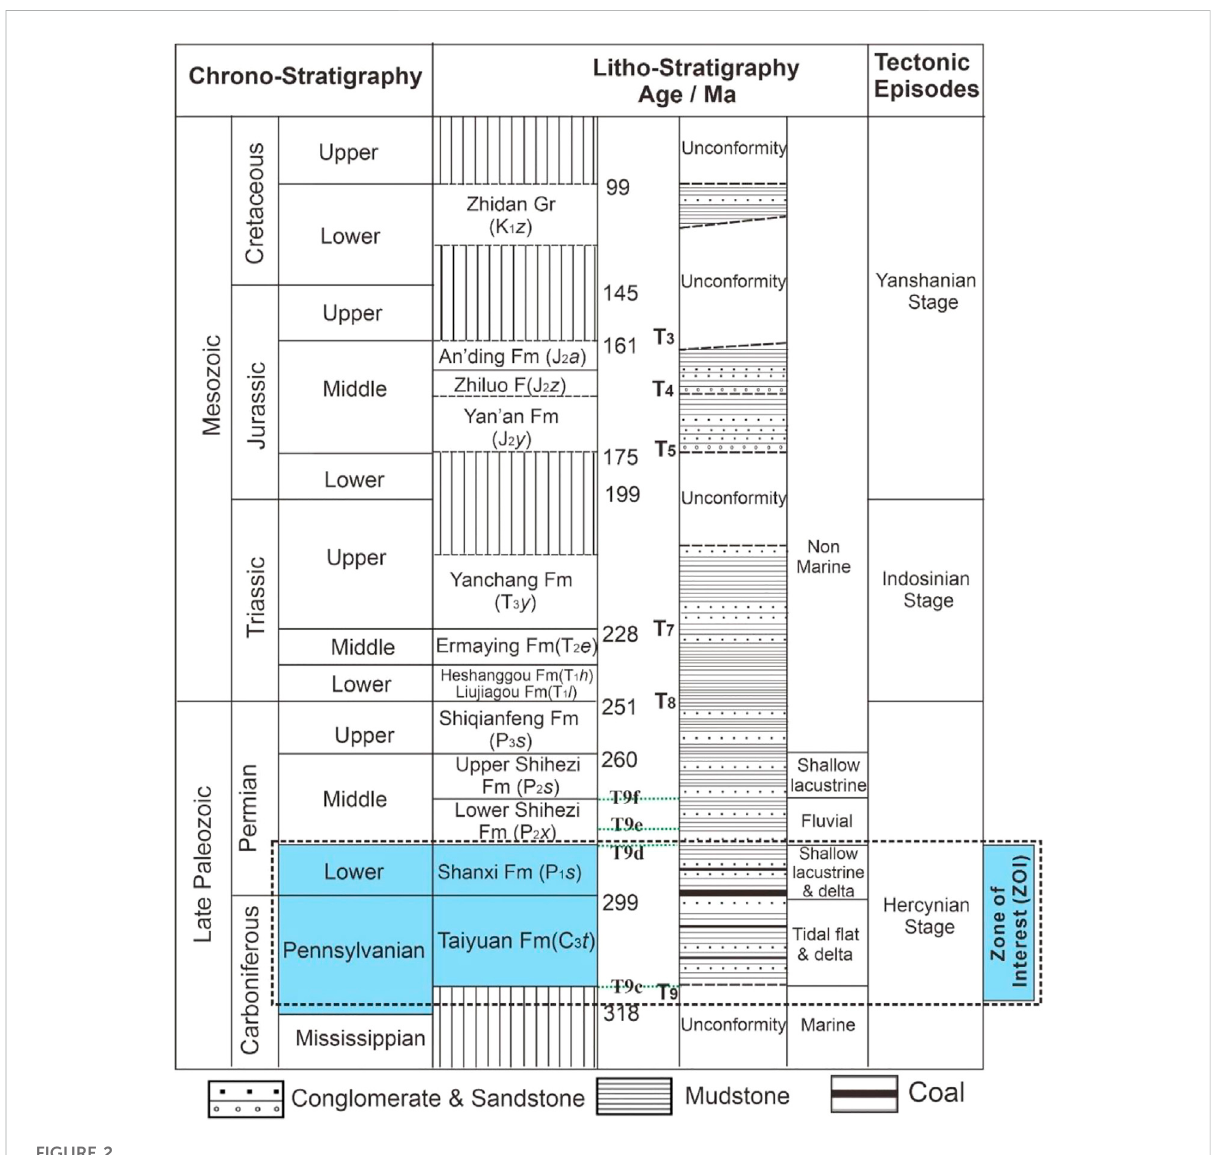
FIGURE 2 Simpli fi ed stratigraphic diagram of the study area. The highlighted blue colored text shows the studied